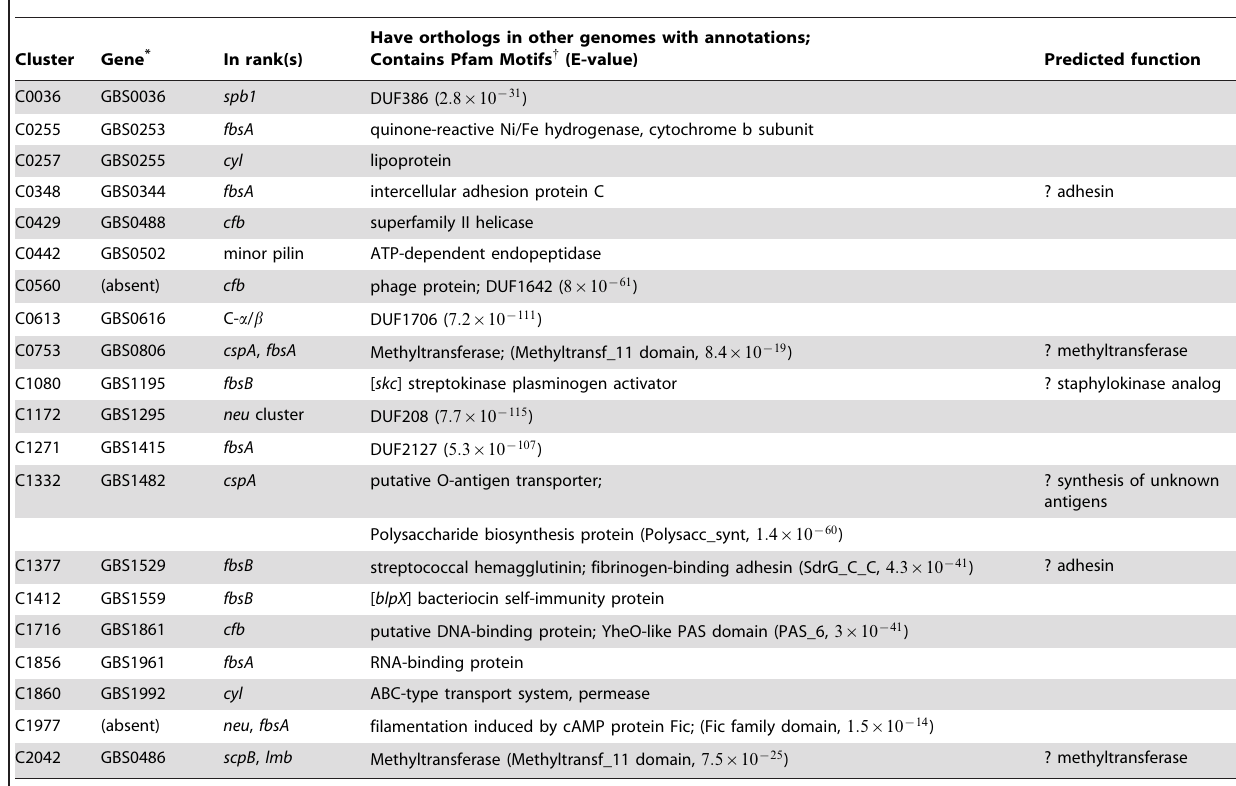
This table lists the genes encoding hypothetical proteins from the top-10 genes of all 15 functional category listed in Table S1. Cluster refers to the homolog clusters